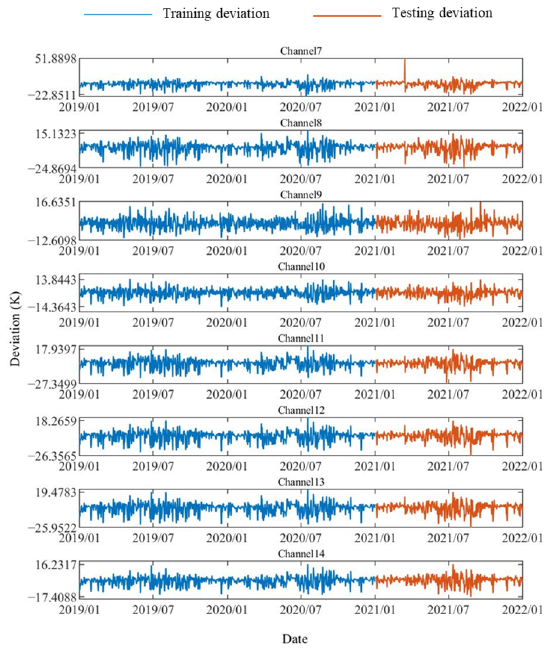
Figure 4. The deviation data at 99.13 ◦ E, 29.68 ◦ N. The training and testing scores of the LSTM model are shown in Table 3. A smaller score, which means a smaller prediction deviation, indicates a better performance of the model. The RMSEs in the channels around the water vapor absorption band (channel 9, 10, and 14) are lower. Among the other channels, the RMSEs in the long-wave infrared channels (channels 11, 12, and 13) are slightly higher than those in the medium-wave infrared channels (channels 7 and 8). The frequency distributions of the deviation values are shown in Figure 7. Most of the deviations are around